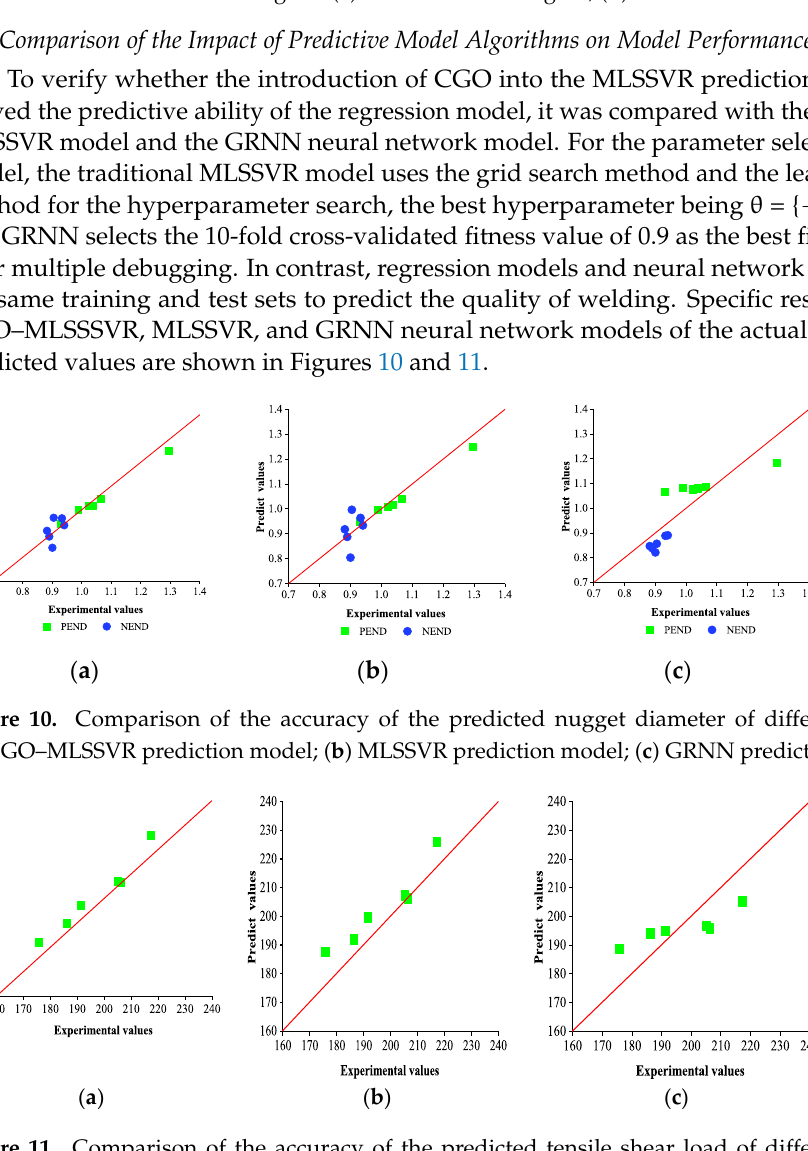
Figure 9. Method II validation figure. ( a ) No. 1 validation figure; ( b ) No. 2 validation figure. Table 9. Method II verification of relative error.